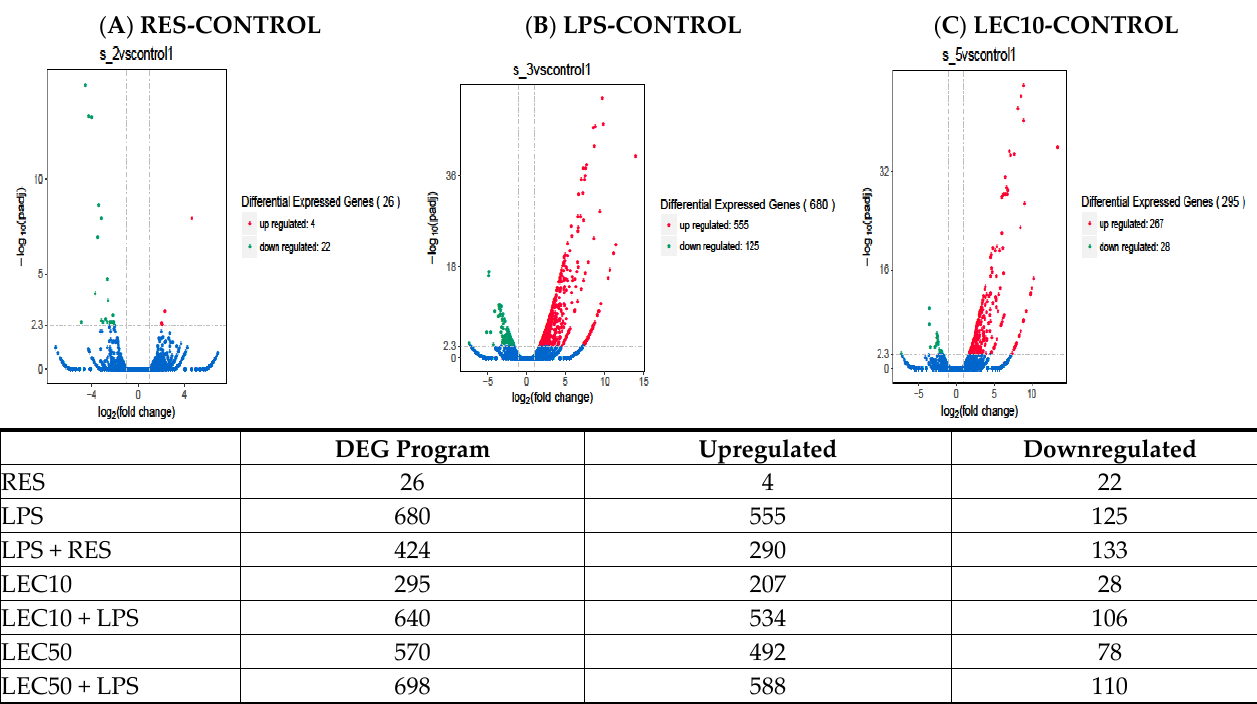
Figure 1. ( A – C ) The role of LPS, LEC10 and RES on gene expression of mediators involved in the agonist-induced signal transduction. Human PBMCs were treated with three compounds and the vehicle control for 3 h. RNA was extracted from the cells and analyzed using RNAseq. These data were obtained by using the DEG analysis. Volcano diagram depicts the differentially expressed genes (DEG) program data induced by LPS, LEC10 (red) and downregulated (green) by RES (-) and the table inset shows the number of DEG program data that are either upregulated or downregulated. This Log2 ratios DEG program data were downloaded into Ingenuity Pathways Analysis and Z score values (higher Z scores represent significant pathways) were obtained. Volcano diagram based on the DEG program data from PBMCs treated with RES, LPS or LEC10 (following table for Figure 1A–C). Genes that were modulated by RES are listed in Table 2, respectively. Downregulated genes include those that encode for cytokines such as interleukin 19 ( IL-19 ), interferon-